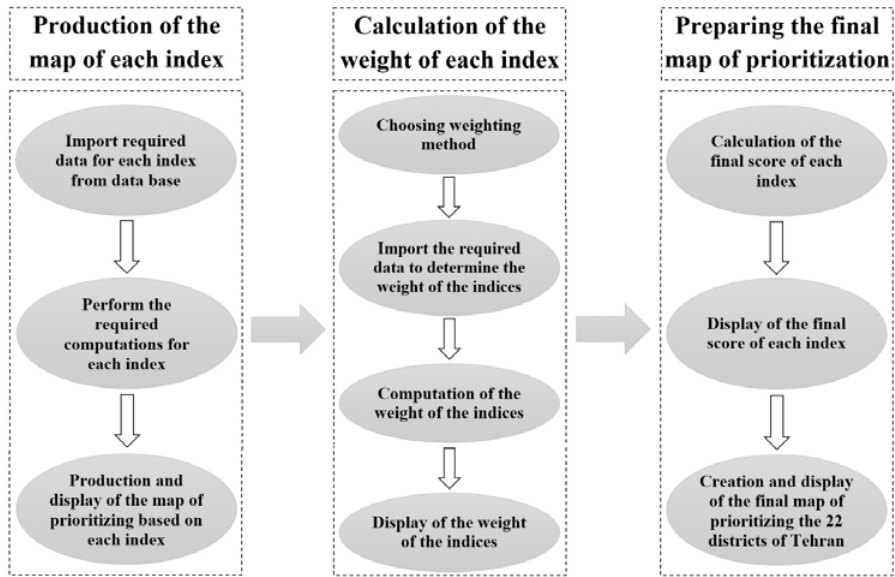
Fig. 3: General view of proposed model: a SDSS for prioritizing 22 districts of Tehran for construction of multiplex buildings